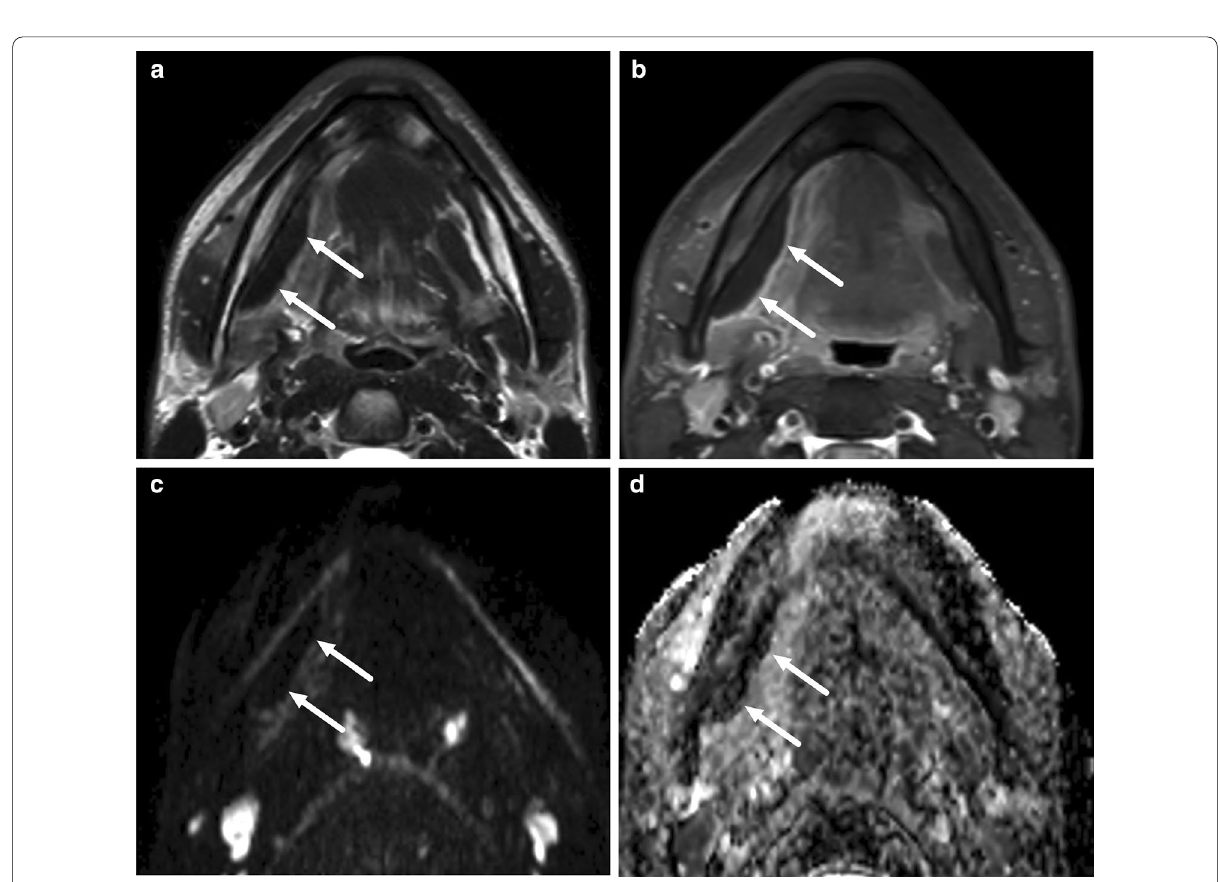
Fig. 33 Subperiosteal hematoma after oral surgery (arrows). The collection is very hypointense on the axial T2-weighted image ( a ) which would be unusual for an abscess but mimics an abscess on the post-contrast fat-suppressed T1-weighted image ( b ). DWI of a hematoma can be misleading: the DWI trace image ( c ) shows T2 dark-through effects, whereas the ADC of the collection ( d ) looks artifactual and not like a true abscess. Surgery found